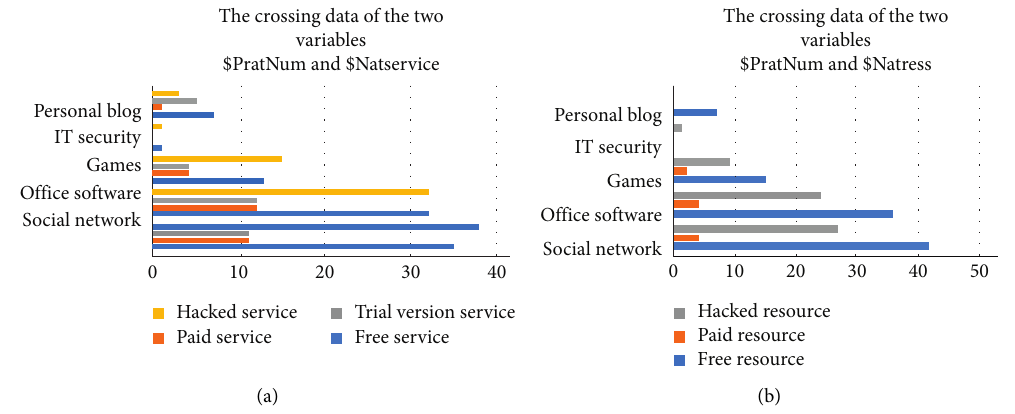
Figure 6: The crossing of the variable $ PratNum with the two variables: (a) $ Natservice and (b) $ NatRess.